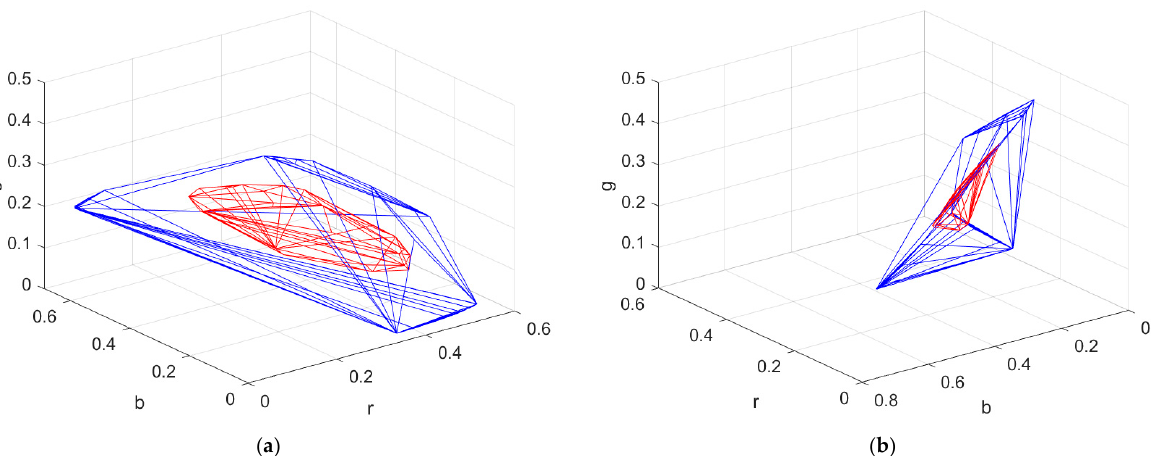
Figure 6. ( a ) The convex hull of the ARSs in the rgb normalized signal space for the RGBF camera. The convex hull of the reference samples is shown in red for comparison. ( b ) The same as ( a ) except for viewing angle.